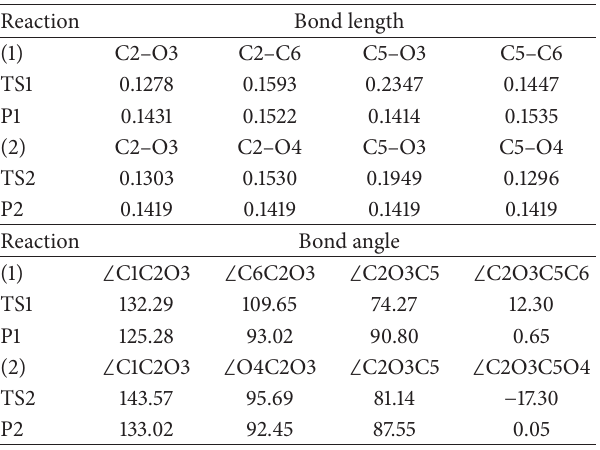
Table 1: The main geometric parameters for transition states (TS1 and TS2) and products (P1 and P2) of dimerization reaction of alkyl ketene (bond length: nm; bond angle: deg.).